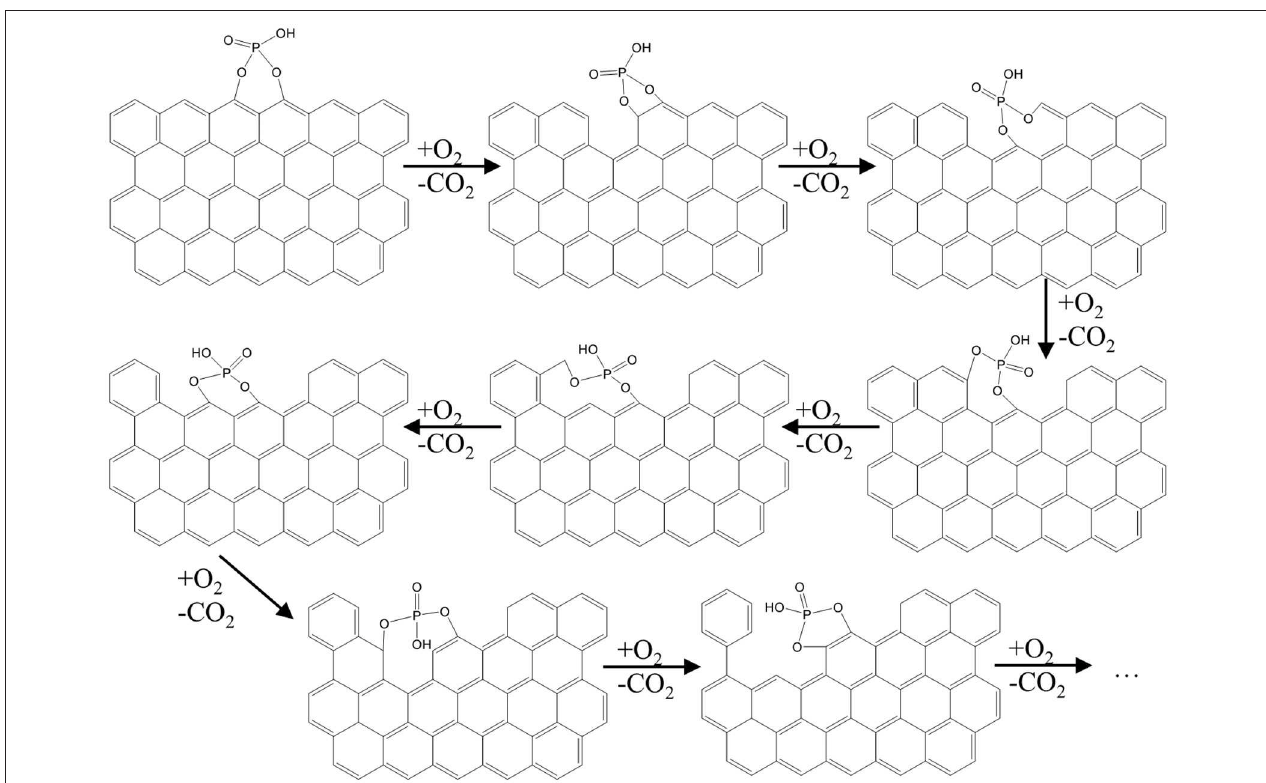
FIGURE 5 | Scheme of a possible gasification mechanism of AC at 900 ◦ C.